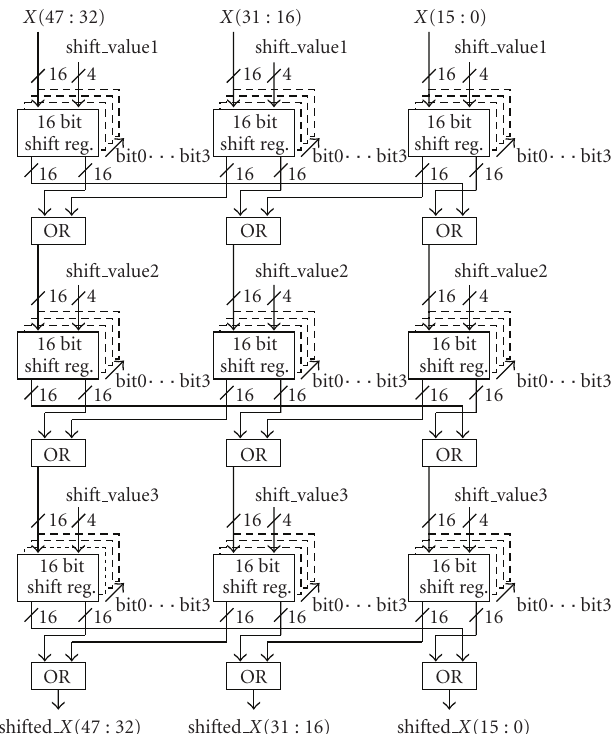
Figure 11: 48-digit cyclic shift register.